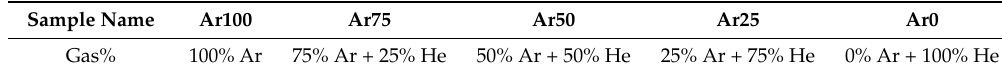
Figure 1. Schematic diagram of arc discharge setup. Table 1. Samples names and corresponding gas condition.